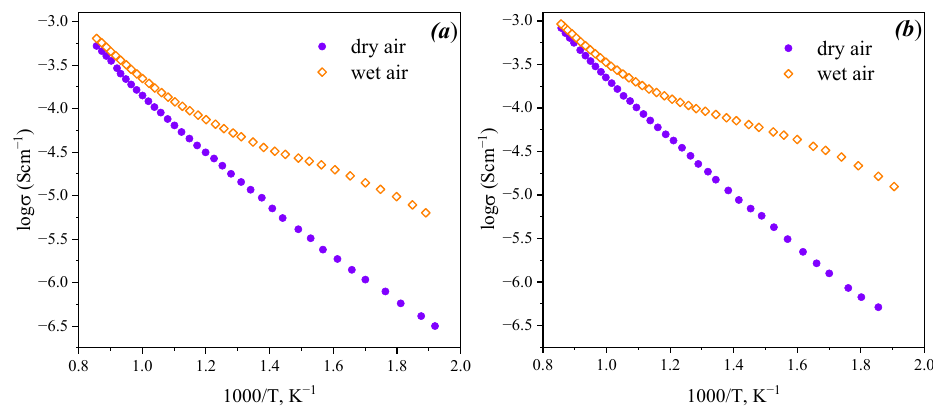
Figure 9. Temperature dependence of total conductivity in dry ( p H 2 О = 3.5·10 −5 atm) and wet ( p H 2 О = 1.92·10 −2 atm) air for Ba 5 In 2 Al 2 ZrO 13 ( a ) and Ba 5 In 2.1 Al 2 Zr 0.9 O 12.95 ( b ).